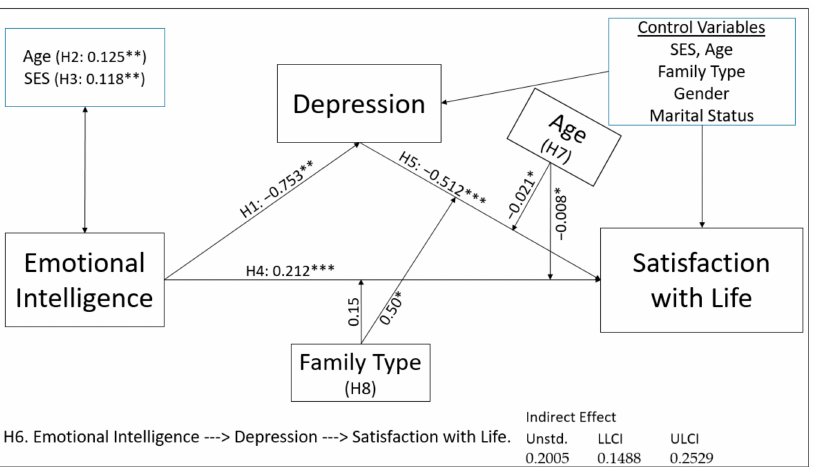
Figure 4. The results of proposed research model, * p < 0.05, ** p < 0.01, *** p <